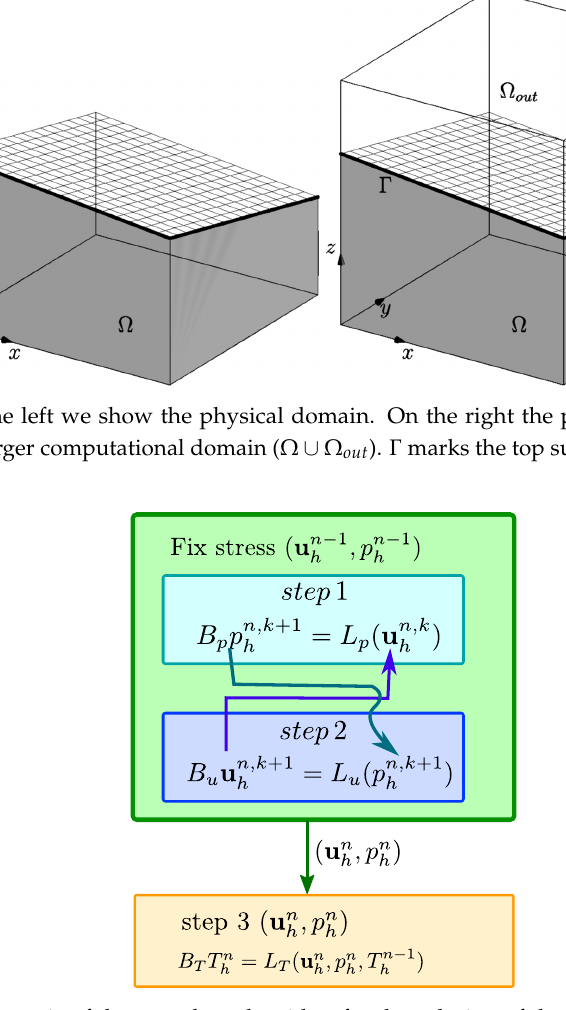
Figure A2. A schematic of the complete algorithm for the solution of the thermal poro mechanical problem. Matrices B u , B p , B T correspond to the discretization of Equations (A1) a , b , c